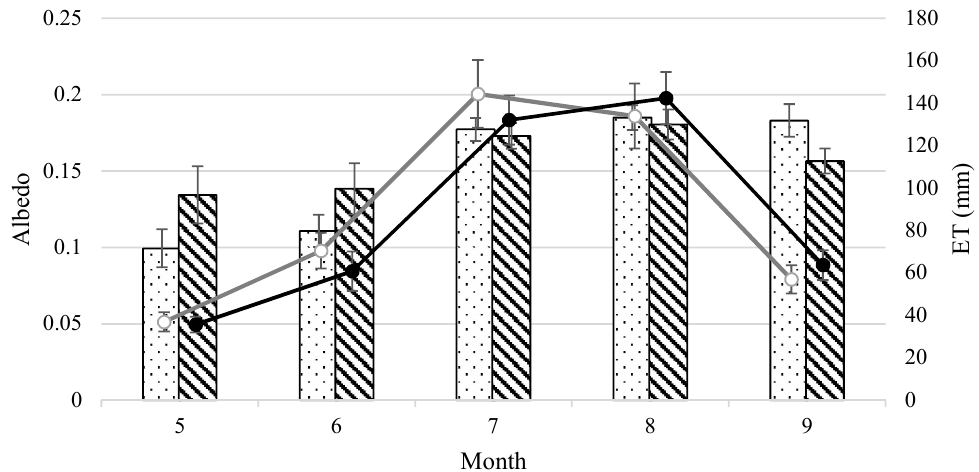
Figure 3. Multi-year (2006–2015) mean albedo and evapotranspiration (ET) for unchanged pure pixels in rain-fed farmland and paddy fields during the growing